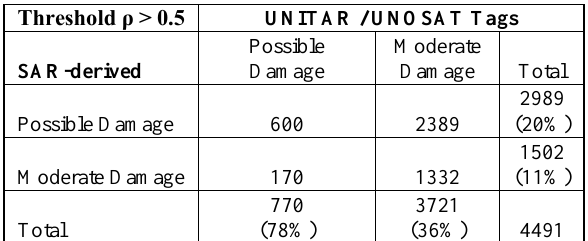
Table 3. Confusion matrix for when threshold for ρ is > 1.5. “No Damage” category from SAR-derived rapid assessment maps is disregarded since UNITAR / UNOSAT tags only use “Possible Damage” and “Moderate Damage” labels.